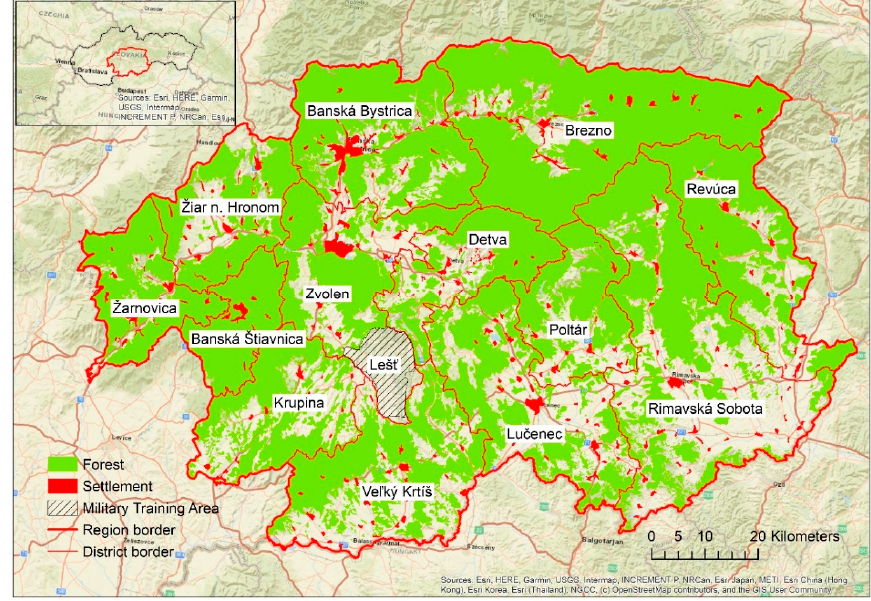
Figure 1. Study area of the Banskobystrický Self-governing Region.